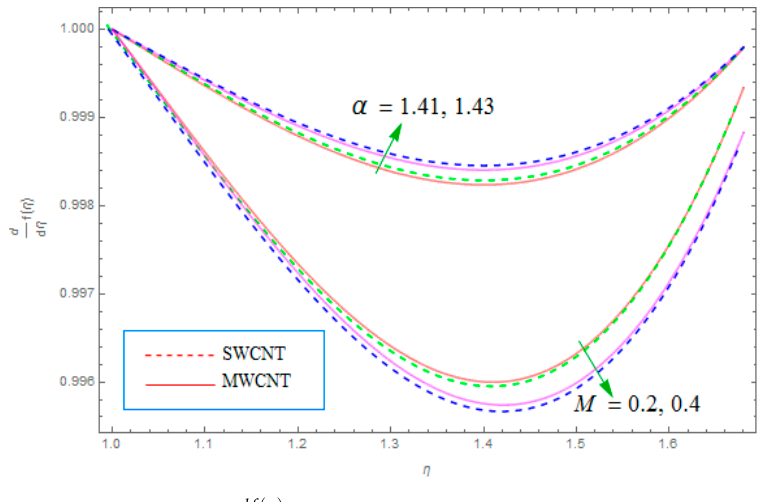
Figure 2. df ( η ) distribution for varying M and α d η